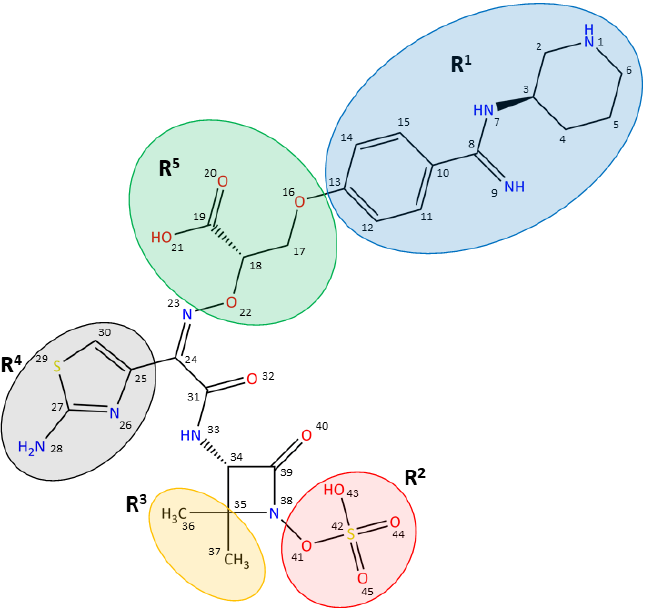
Figure 1. Structure of the monobactam AIC499, obtained by iterative optimization. The relevant functional groups are marked in color: benzamidine-based head group (R 1 ), blue; β -lactam N-1 position (R 2 ), red; β -lactam C-4 position (R 3 ), orange; amino-thiazole (R 4 ), gray; linker (R 5 ), green. Reference 1. Freischem, S.; Grimm, I.; L ó pez-P é rez, A.; Willbold, D.; Klenke, B.; Vuong, C.; Dingley, A.J.; Weiergräber, O.H. Interaction Mode of the Novel Monobactam AIC499 Targeting Penicillin Binding Protein 3 of Gram-Negative Bacteria. Biomolecules 2021 , 11 , 1057. [CrossRef]